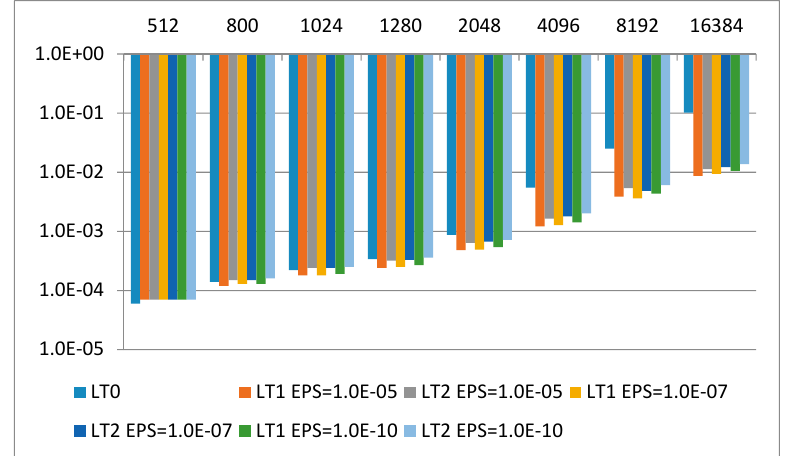
Figure 5. Computational time for di ff erent Legendre transform algorithms with CMAX = 64 (LT0 is the algorithm using DGEMM, LT1 is the butterfly algorithm and LT2 is the proposed method, EPS is desired precision in interpolative decomposition, CMAX is the number of columns in each sub-matrix on level 0, Unit: Second).